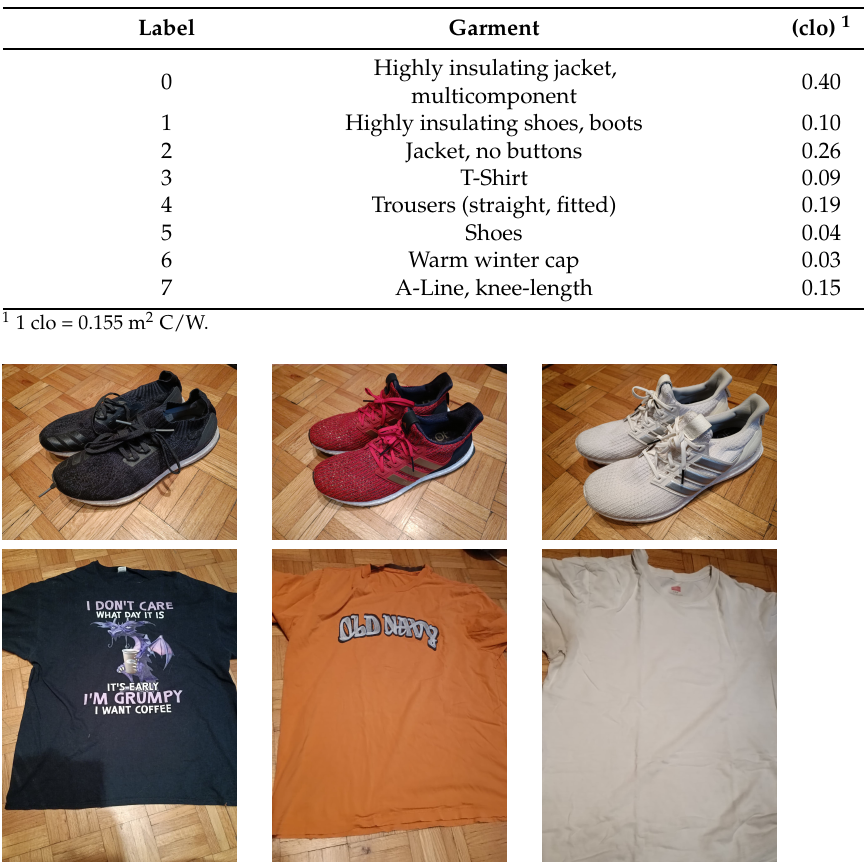
Figure 10. Example of three different garments for two